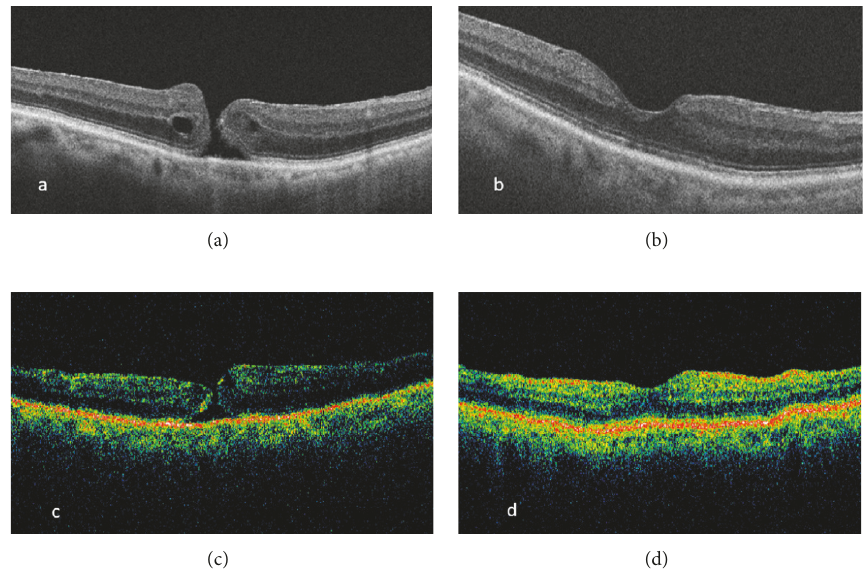
Figure 3: Optical coherence tomography showing (a) full thickness macular hole, (b) first closure of the macular hole, (c) reopening of the macular hole, and (d) second closure of macular